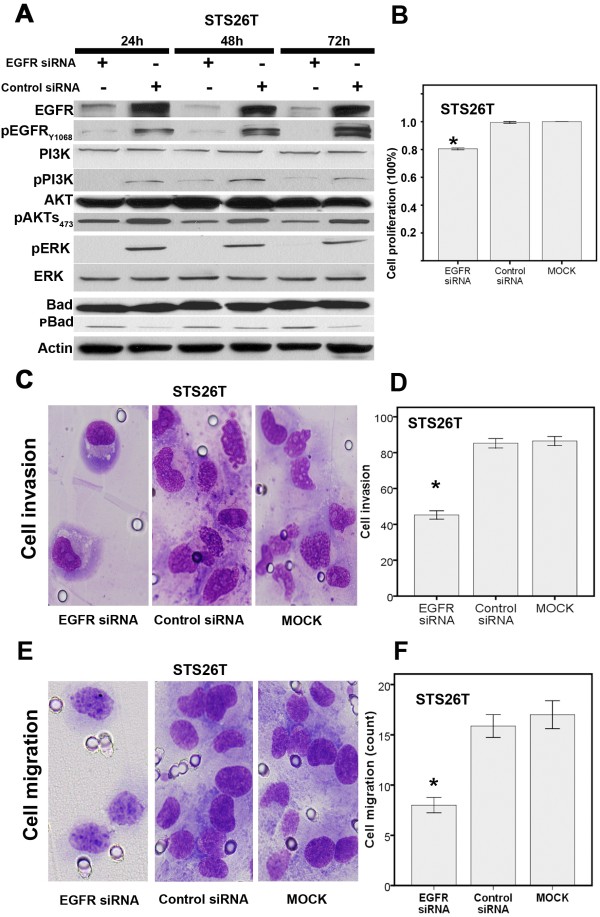
Down-regulation of EGFR by EGFR siRNA in STS26T MPNST cells significantly decreased tumor cell proliferation, invasion, and migration by blocking the PI3K/AKT and MAPK pathways. (A)EGFR siRNA decreased EGFR expression and activation. Activated forms of PI3K/AKT and MAPK pathway factors decreased with EGFR inhibition. (B)EGFR siRNA significantly decreased tumor cell proliferation compared with the nonspecific control siRNA. (C, D)EGFR siRNA significantly decreased tumor cell invasion compared with the nonspecific control siRNA: cell invasion (C) and cell counts (D). (E, F)EGFR siRNA significantly decreased tumor cell migration compared with the nonspecific control siRNA: cell migration (E) and cell counts (F). * indicate P-values <0.05.